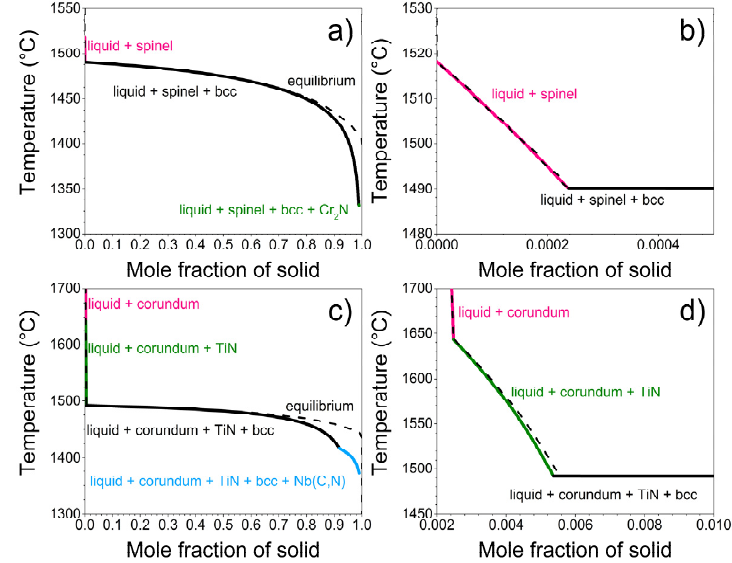
Figure 3. ( a ) Solidification pathway for the SS446 alloy showing presence of spinel, bcc and Cr 2 N; ( b ) shows a magnified region of the early solidification from ( a ). ( c ) Shows the solidification pathway of the SS441 alloy and ( d ) a magnified region of the early solidification from ( c ). ( c , d ) Are adapted from ref. [7] to facilitate the discussion.